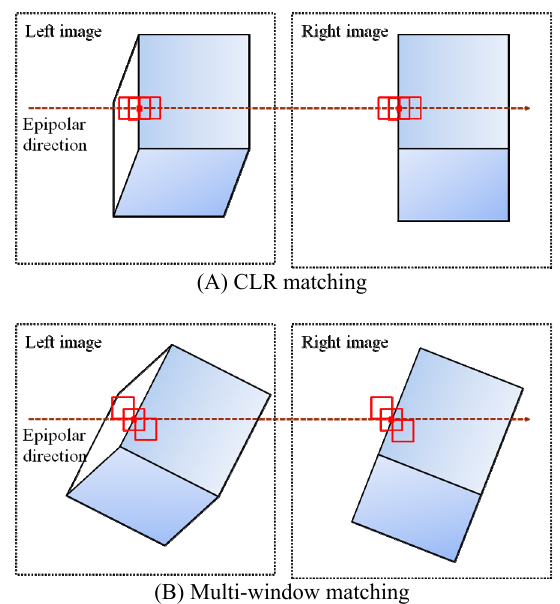
Figure 1. Illumination of the difference between CLR matching and Multi-window